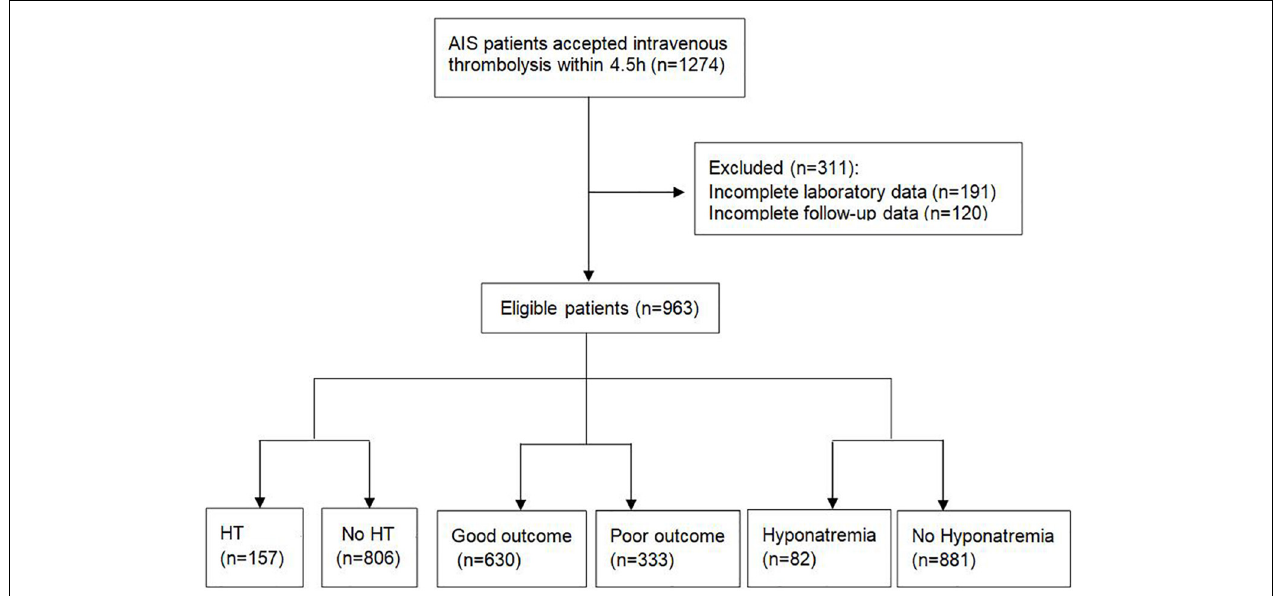
FIGURE 1 | A flowchart of the study. AIS, acute ischemic stroke; HT, hemorrhagic